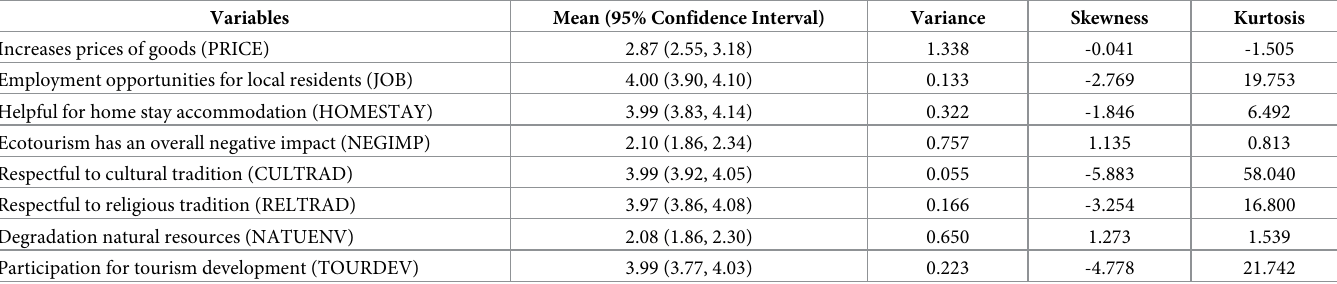
Table 3. Univariate descriptives of selected variables (Sample size, n = 310).